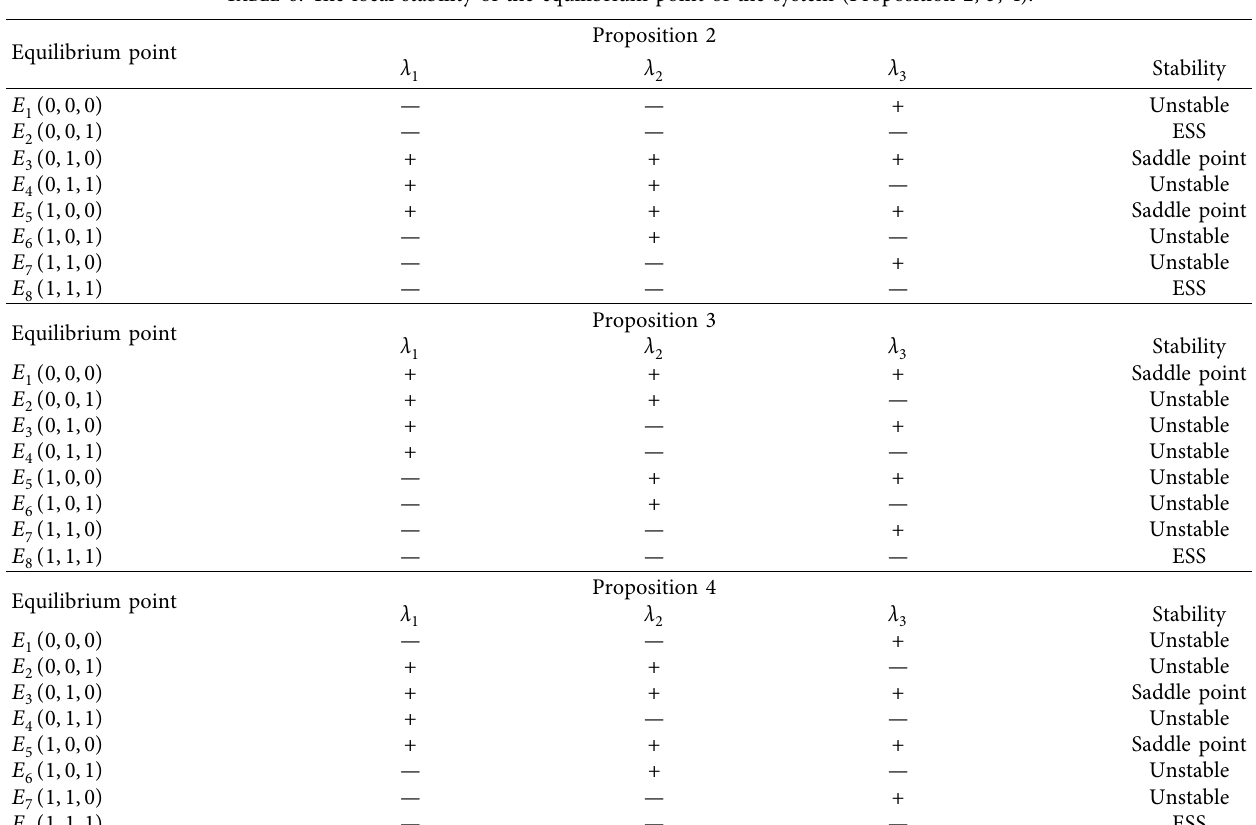
Table 6: The local stability of the equilibrium point of the system (Proposition 2, 3, 4).